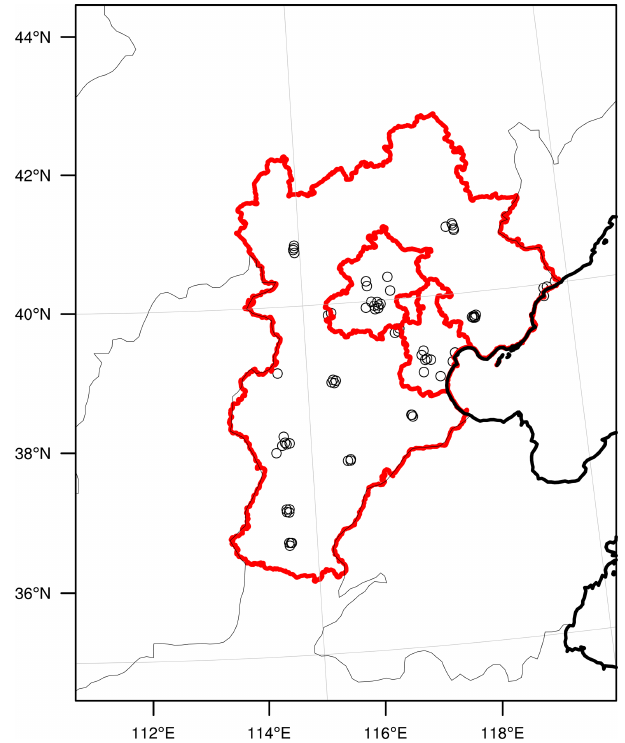
Figure 1. Map of the current environmental monitoring stations (hollow circles) within the BTH domain. The thin black lines show the boundaries of the surrounding Chinese provinces, and the thick black lines show the coastline. The boundaries of Beijing, Tianjin and Hebei Province are marked in red.